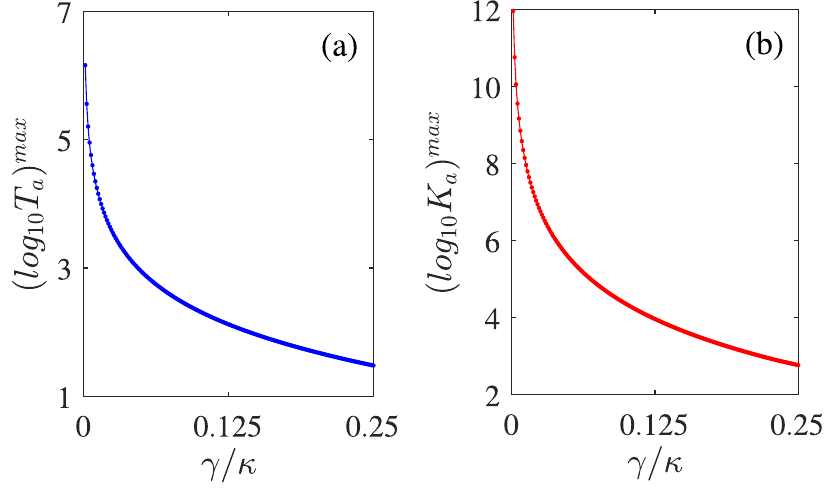
Figure 6. The maximal logarithms of T a ( a ) and K a ( b ) versus the QE spontaneous decay rate γ in the PT -symmetric case of κ b = − κ and g = 0.45 κ . Other parameters are the same as for Figs 2 and